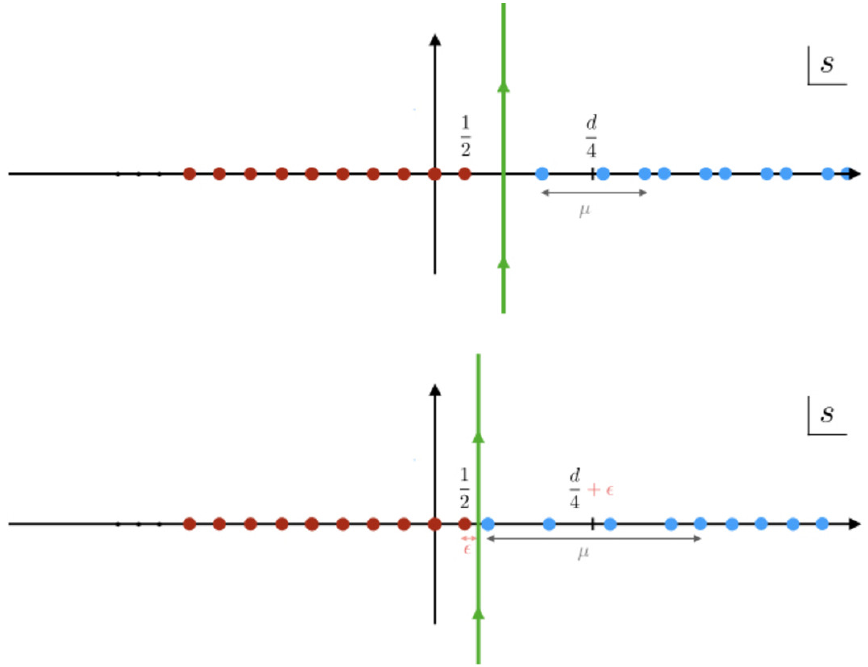
Figure 5. Poles of the Mellin representation for the conformal structure (3.24) when the n -th scalar does not lie on the Principal Series, (cid:23) n = i(cid:22) with (cid:22) 2 R . For ease of presentation, we display the n = 3 case. As (cid:22) varies, the poles of (cid:0) of (cid:0) (2 s (cid:0) 1) (in red) remain (cid:12)xed. When (cid:22) = d them (in Green) becomes pinched. The pinching is regulated by sending d ! d + (cid:15) , with (cid:15) >